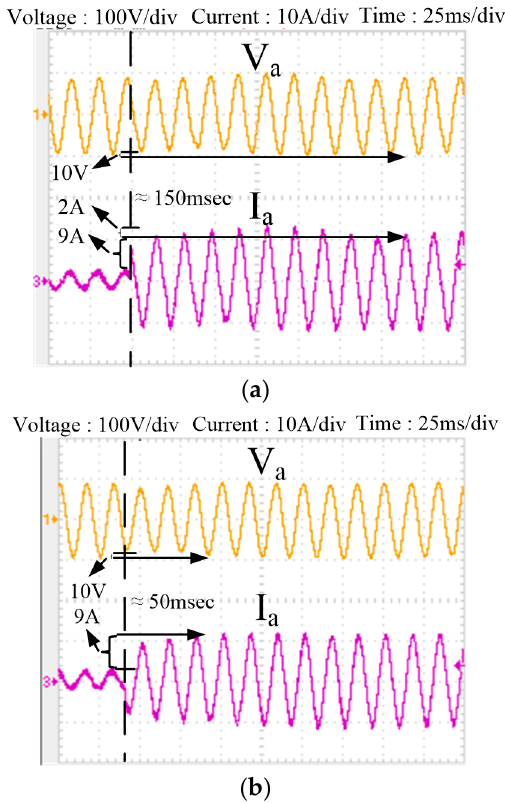
Figure 22. Voltage waveforms when the 1000 W load was instantaneously loaded to a VSI with ( a ) Dual PR controller ( b ) PR controller combined with PC controller. ( a ) Dual PR controller ( b ) PR controller combined with PC